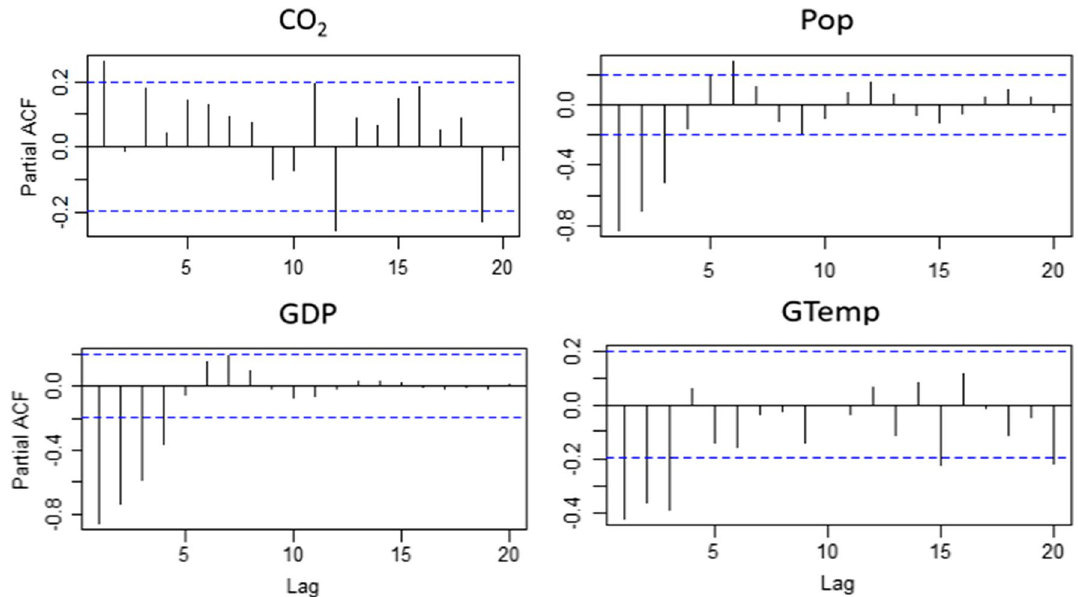
Fig. 6 PAF with different lags of the observed stationary data (blue dashed line: significant interval)